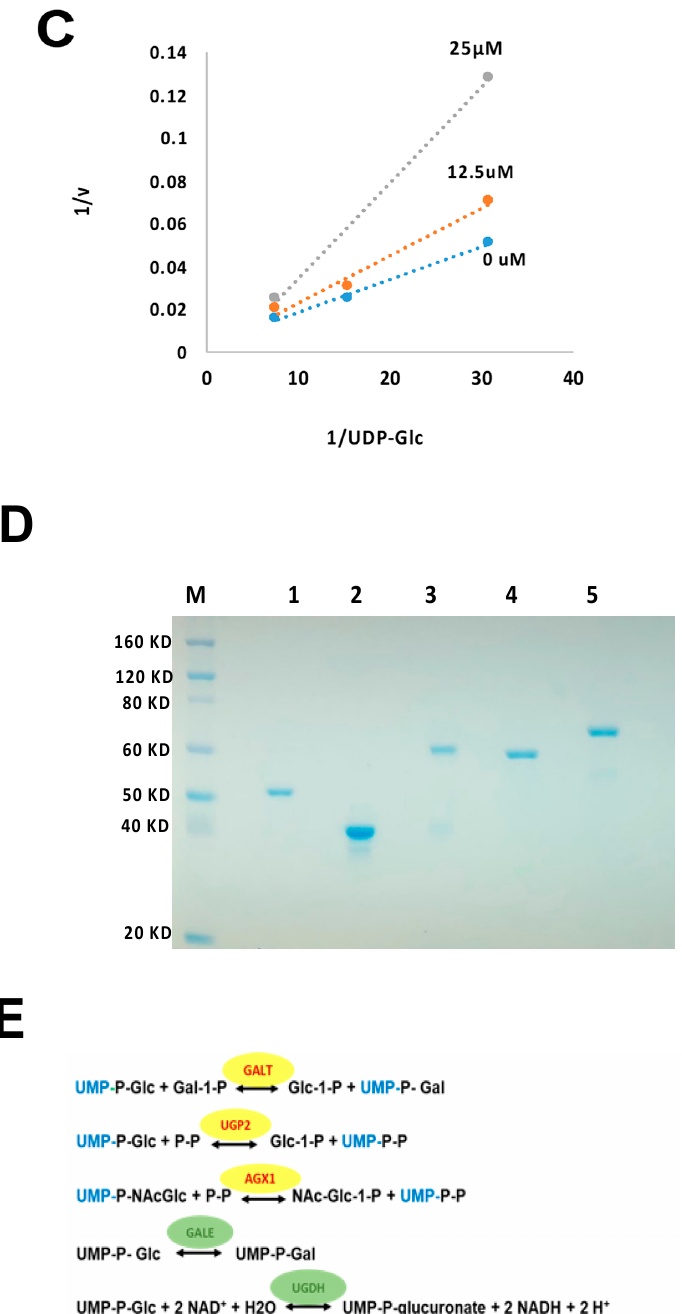
Figure 2. In vitro characterization of fragment GAL-012. ( A ) GAL-012 (orange) docked into GALT. ( B ) Chemical structure of fragment GAL-012. ( C ) Lineweaver-Burke plot of GALT reaction velocities as measured in varying concentrations of GAL-012. ( D ) SDS-PAGE of selected purified recombinant enzymes (M: Molecular weight marker; 1: Purified GALT; 2: Purified GALE; 3: Purified UGDH; 4: Purified UGP2; 5: Purified AGX1 / UAP1.) ( E ) Reaction mechanisms of selected enzymes—GALT, UGP2, AGX1/UAP1, UGDH, GALE.